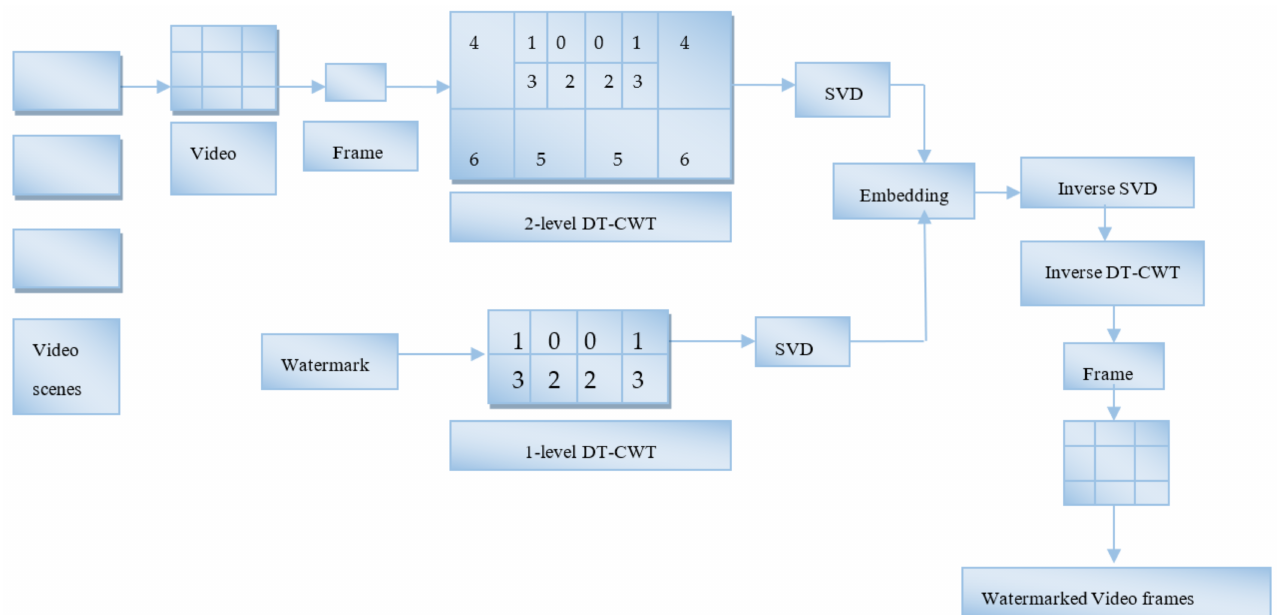
Figure 4. DT-CWT watermark embedding procedure in video frames.